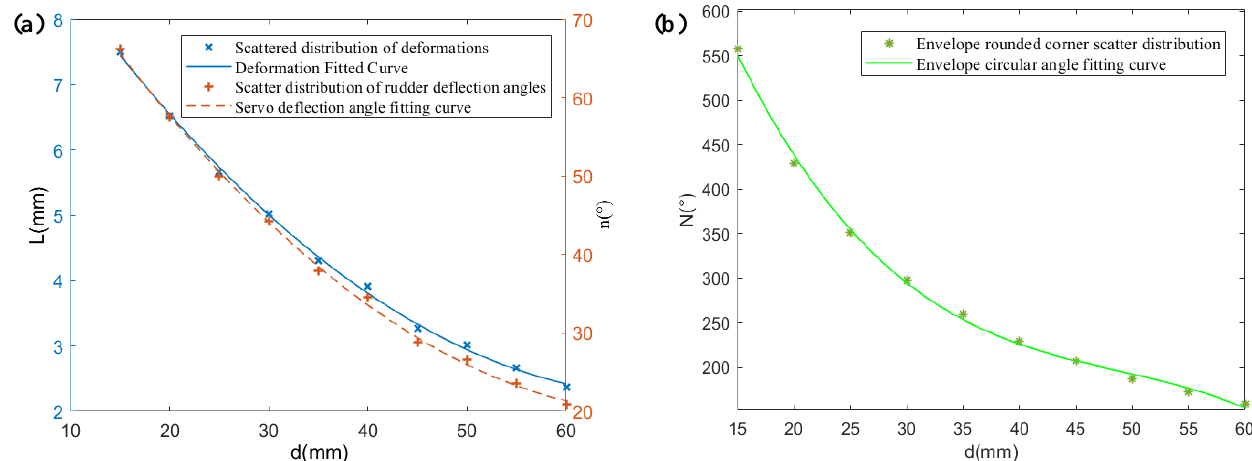
Figure 5. Grab fit curves. ( a ) L and n curve fit results. ( b ) Envelope angle N curve fit results. When the claw toe grips an object, the claw toe is in contact with the surface of the object and the gripping force of the claw toe on the object is generated by the rudder and transmitted by the line. Theoretically, the greater the weight of the object, the greater the gripping force required, i.e., the greater the force exerted by the line on the lower surface of the line holes in each part of the claw toe, which can easily cause damage to the claw toe. A simplified model was established, with the claw toe in contact with the surface of the object, the finger bones on the upper side of the claw toe articulated with restraint and a force of 5 N applied to the lower surface of the fishing line hole in the direction perpendicular to the toe bone and toe tip. The stress and displacement results are shown in Figure 6, the maximum stress 9.742 × 10 5 N/m 2 and the maximum displacement 4.465 × 10 − 4 mm are at the fishtail hole, and the stresses and displacements decrease from